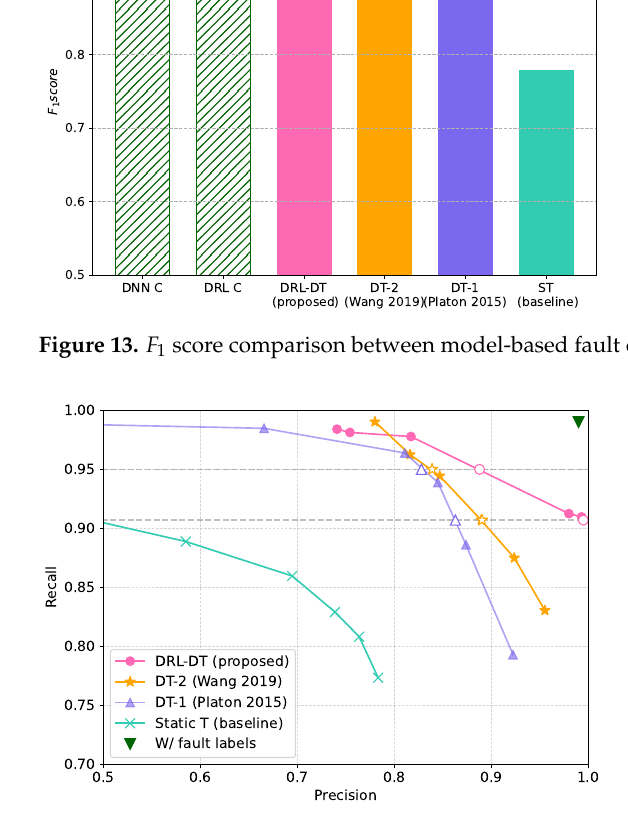
Figure 14. Recall and precision curves for proposed and conventional fault detection schemes [15,49]. Table 2. Performance comparison for inverter fault detection